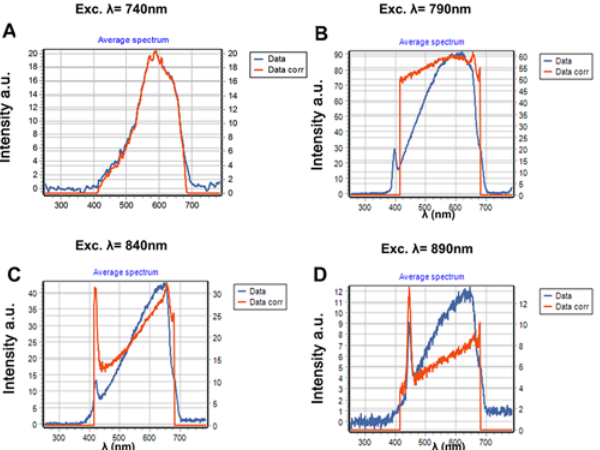
the SHG signal starts to be observed. (D) At 890 nm the fluorescence mCherry is not excited and we can only see a strong SHG in addition to the broad fluorescence from the nanoparticle.